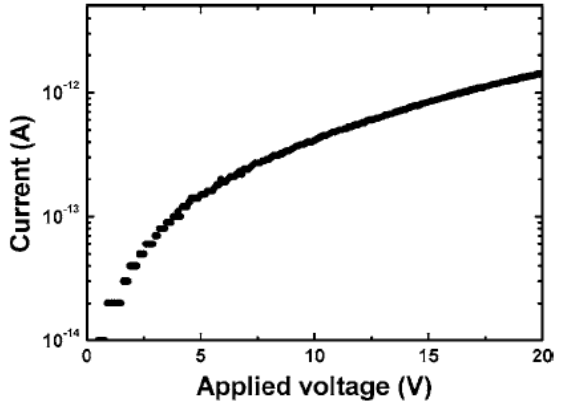
Figure 10. Dark I-V characteristics of the MSM diamond photoconductor (reprinted from Reference